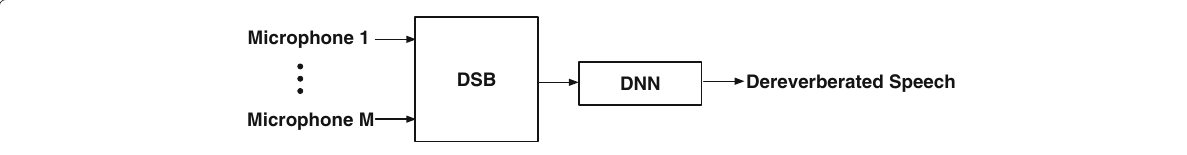
Fig. 1 A block diagram of the DSB-DNN